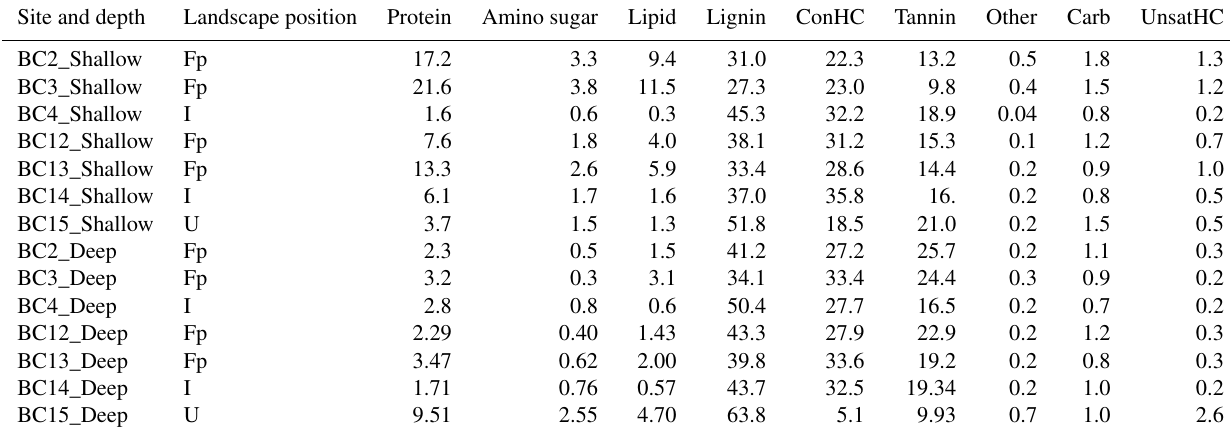
Table 1. Relative peak abundances (%) of compound classes in the water-extracted organic carbon fraction averaged across replicates per site. Samples are ordered according to their depth profile (shallow and deep) and their relative position in the landscape: floodplain (Fp), inland (I), and upland (U). Abbreviations: ConHC (condensed hydrocarbon), UnsatHC (unsaturated hydrocarbon), and Other (no classification assigned).